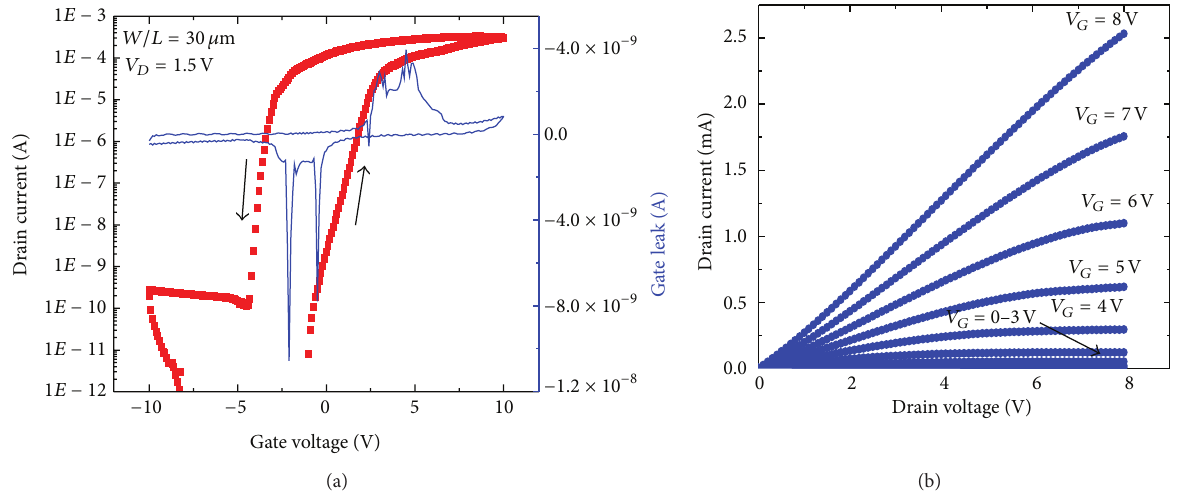
Figure 4: (a) Transfer and (b) output characteristics of the fabricated FGT